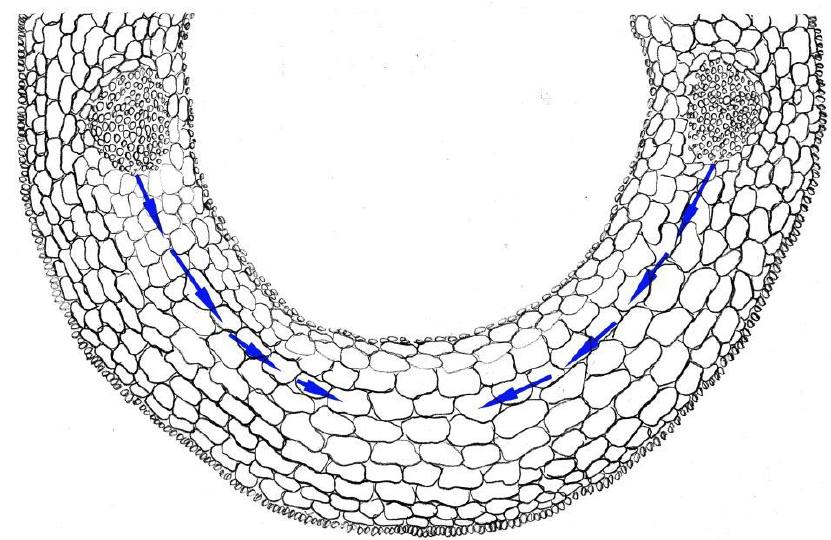
Figure 1. Scheme of cross-section of rice coleoptile. Arrows indicate the water pathway from vascular bundles to elongating cells. This figure was drawn by Dr. G. Sharipova on the basis of microscope observation.